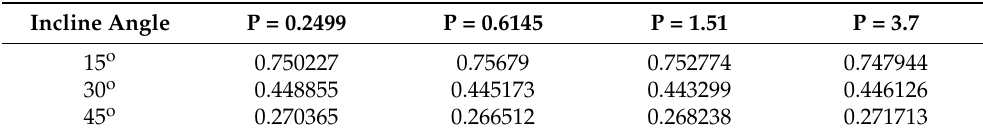
Figure 12. Nu and Fanning factor of the hot fluid channel. Table 5. Comprehensive factor at different angles.